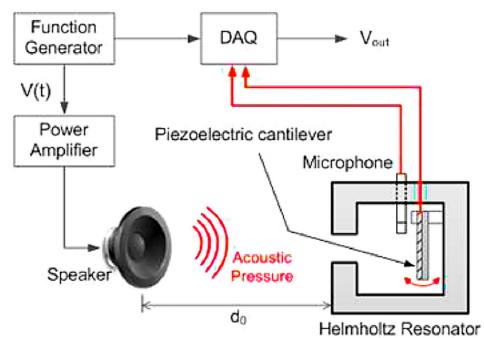
Figure 6. Polyvinylidene difluoride (PVDF) cantilever beam inside the Helmholtz resonator to achieve AEH. Reproduced with permission from [37]; published by Springer, 2013.